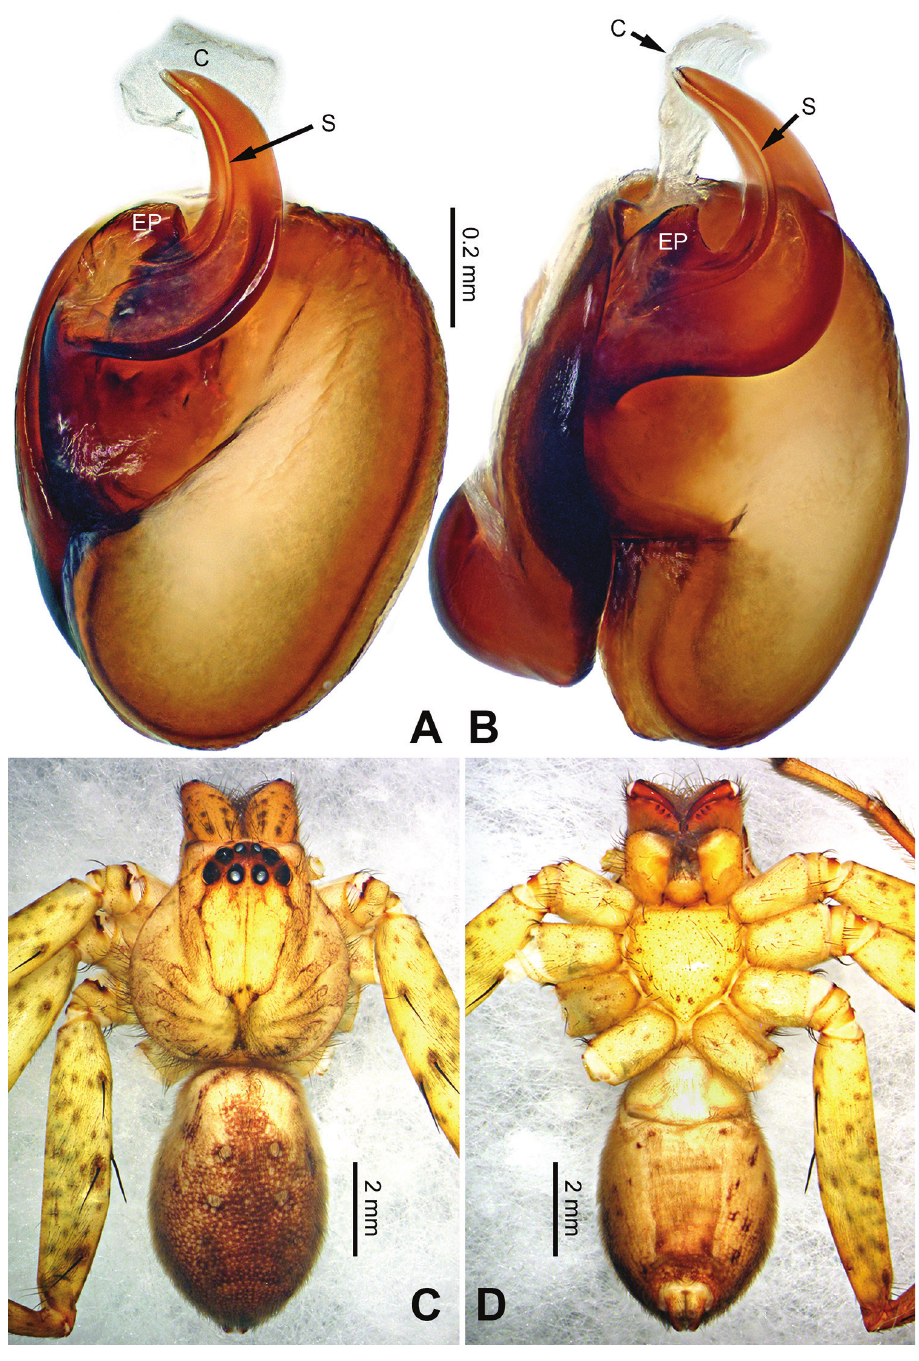
Figure 19. Pseudopoda putaoensis Zhao & Li, sp. n., male holotype. A Bulb, ventral view B Bulb, dorsal view C Habitus, dorsal view D Habitus, ventral view. Scale bar equal for A, B